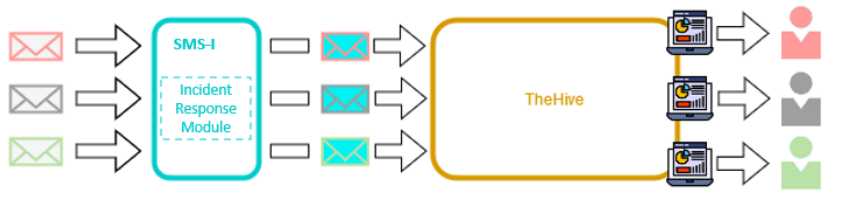
Figure 21. SMS-I Incident Response module information